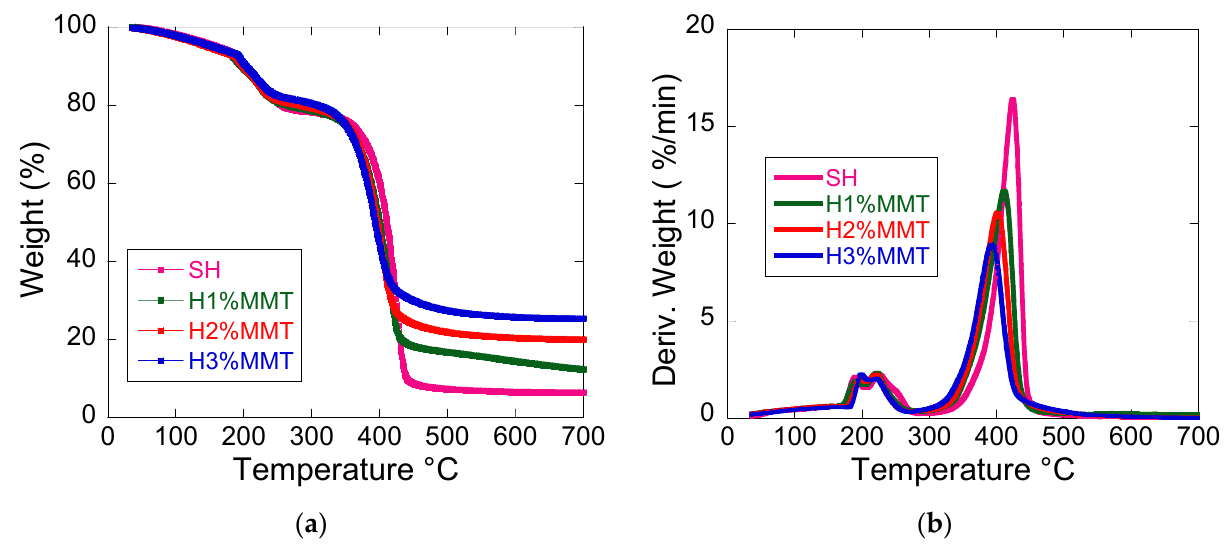
Figure 7. TGA ( a ) and TDG ( b ) curves of the obtained composite hydrogels. SH: 10%MAA, 2 mol%BIS based on MAA, 0%MMT.